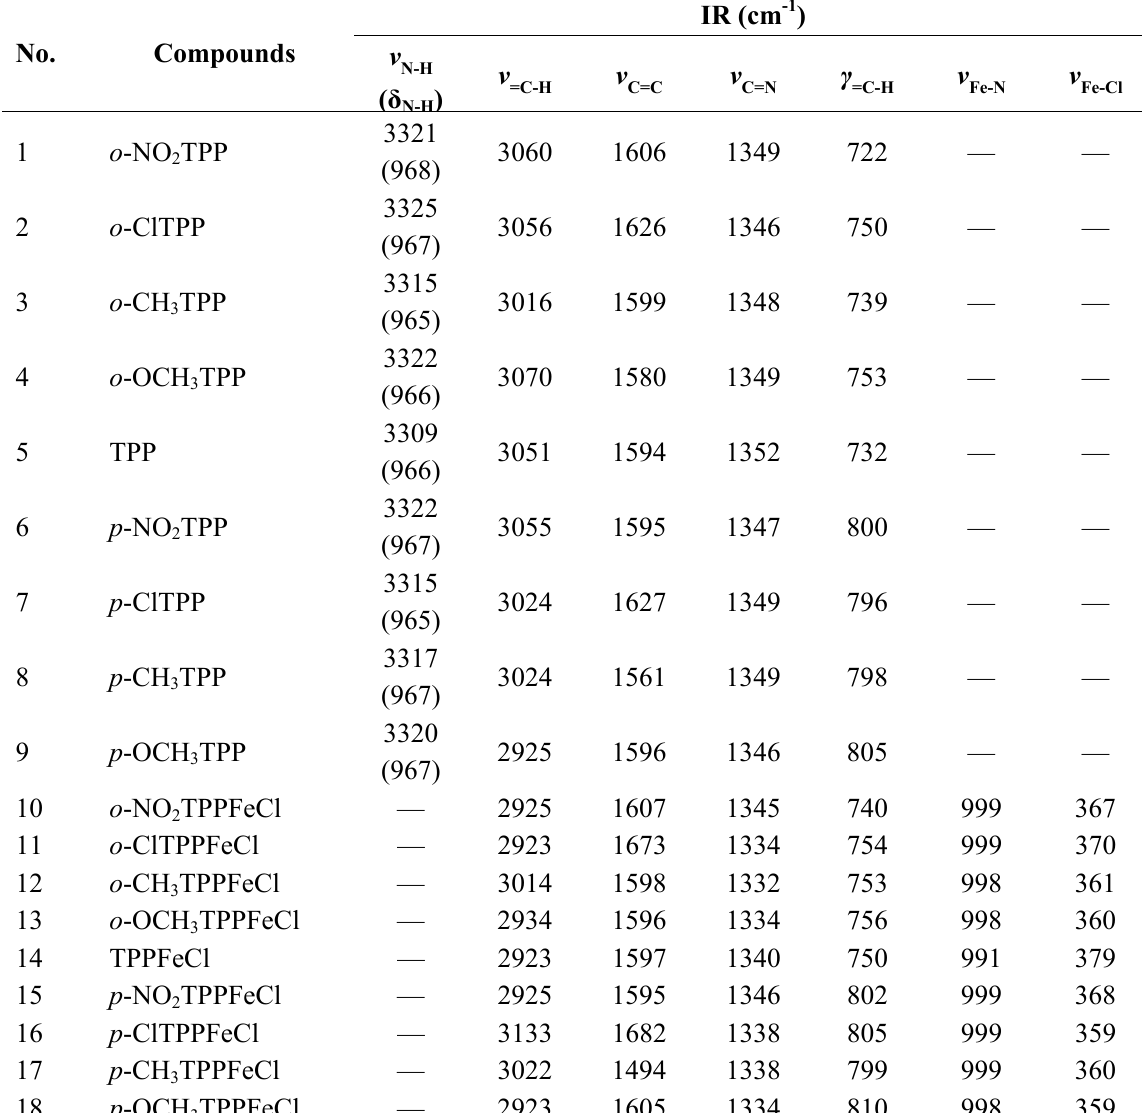
Table 3. IR/FIR data of free base porphyrins and iron porphyrin